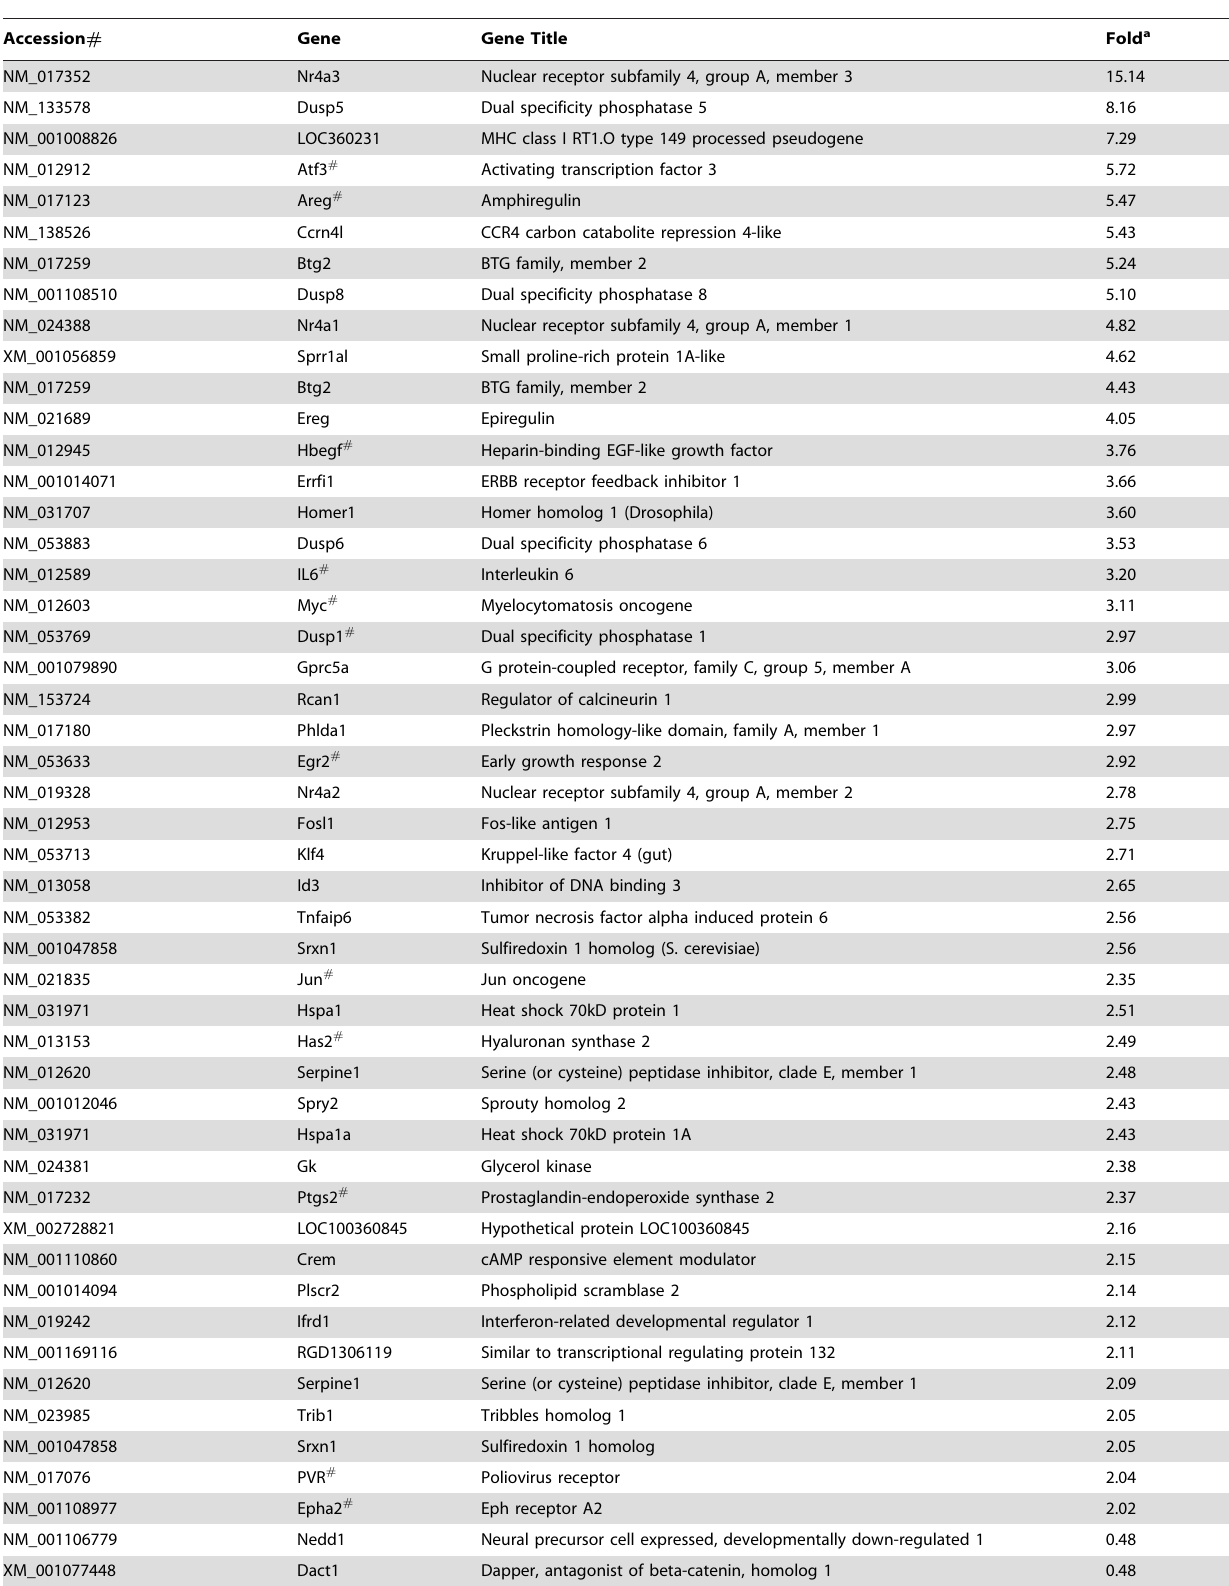
Table 1. Up- and downregulated Genes (p , 0.05, more than twofold change) in Mu¨ller cells after stretching for 1